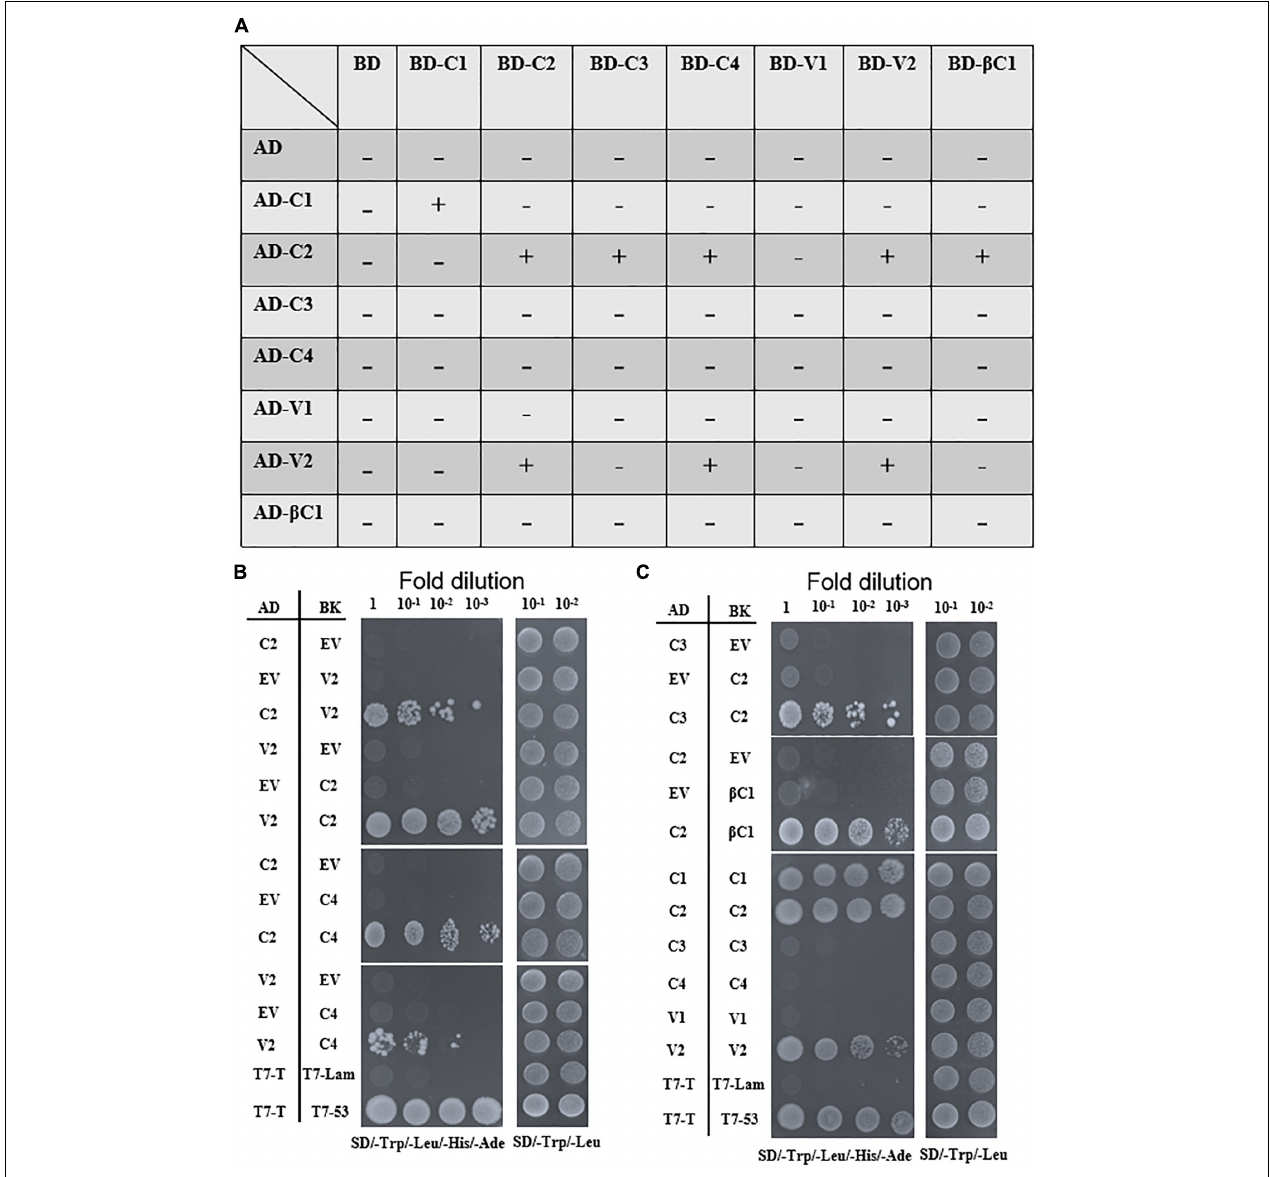
FIGURE 6 | Yeast two-hybrid assays among TYLCCNV/TYLCCNB-encoded proteins. (A) Summary of Y2H assay results. “–” means no positive interaction was detected; “+” means a positive interaction was detected. The Y2H assays summarized in this table were repeated at least three times by each independent transformation. (B) Interactions between C2 and V2, C2 and C4, and V2 and C4 by Y2H. (C) Interactions between C2 and C3, C2 and β C1, and self-interactions of C1, C2, and V2 by Y2H. The Y2H Gold yeast strain cells co-transformed with the indicated plasmids were plated on synthetic dextrose (SD)/-Trp, -Leu, -His, -Ade medium to identify protein interactions. Photographs were taken at 4 days post-transformation. Yeast cells co-transformed with pGADT7-T and pGBKT7-Lam were used as negative controls, and with pGADT7-T and pGBKT7-53 were used as positive controls (B,C)